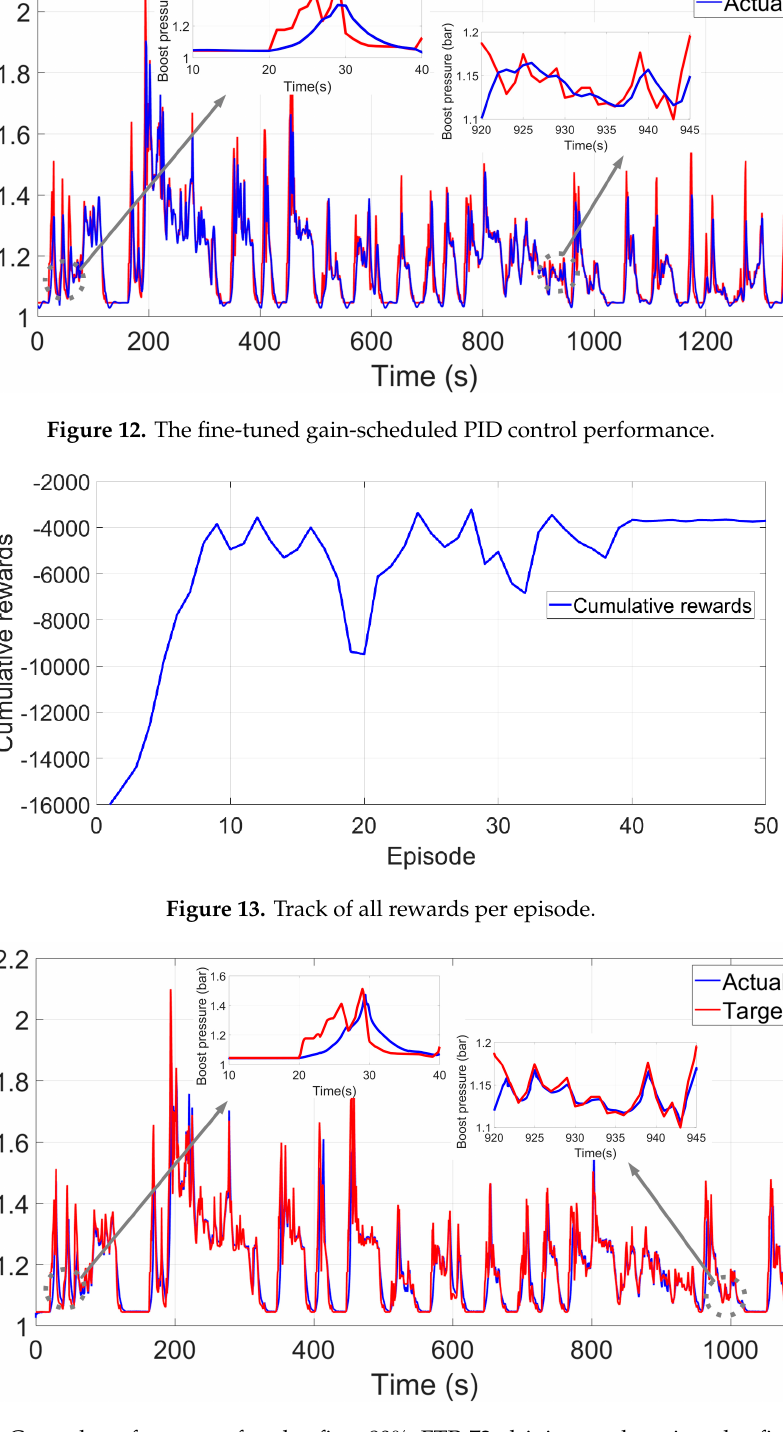
Figure 14. Control performance for the first 80% FTP-72 driving cycle using the final DDPG training parameters.